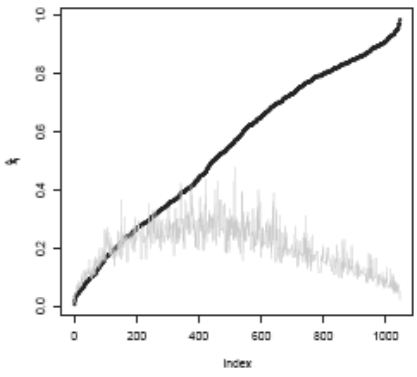
Figure 5 – Sorted estimates ˆ